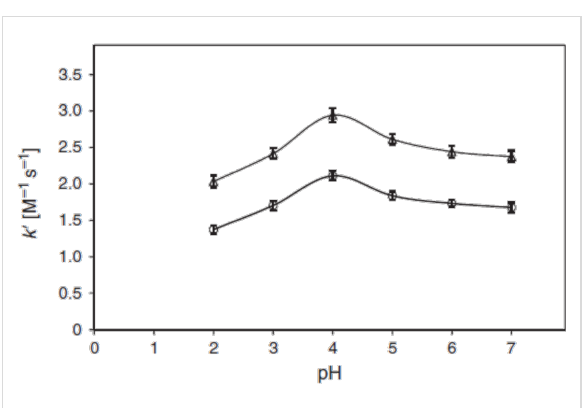
Figure 5: k' –pH profiles for the photolysis of FMF (10 − 4 M) in acidic solution under aerobic ( ○ ) and anaerobic ( ∆ ) conditions. Experimental conditions are the same as in Figure 4. Reproduced with permission from [32]. Copyright 2013 CSIRO